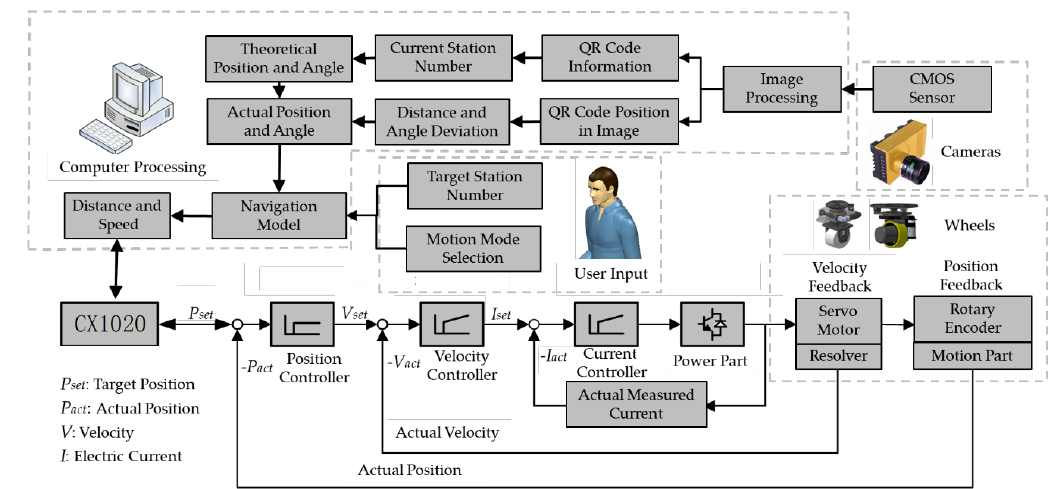
Figure 3. Working principle of the navigation system.